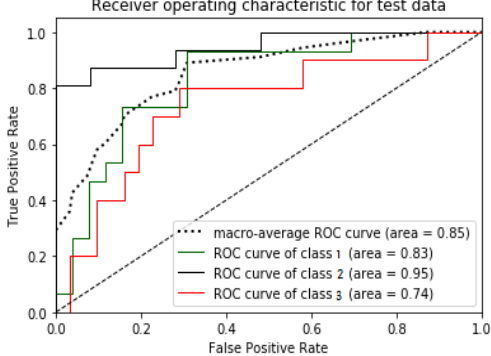
Figure 9. Ecuador—ROC curves for each class of test dataset. The sample data for classes 1 and 2 are classified better than class 3, as the curve for class 3 is below the threshold. The result also indicates that the false positive rate for class 3 is high.